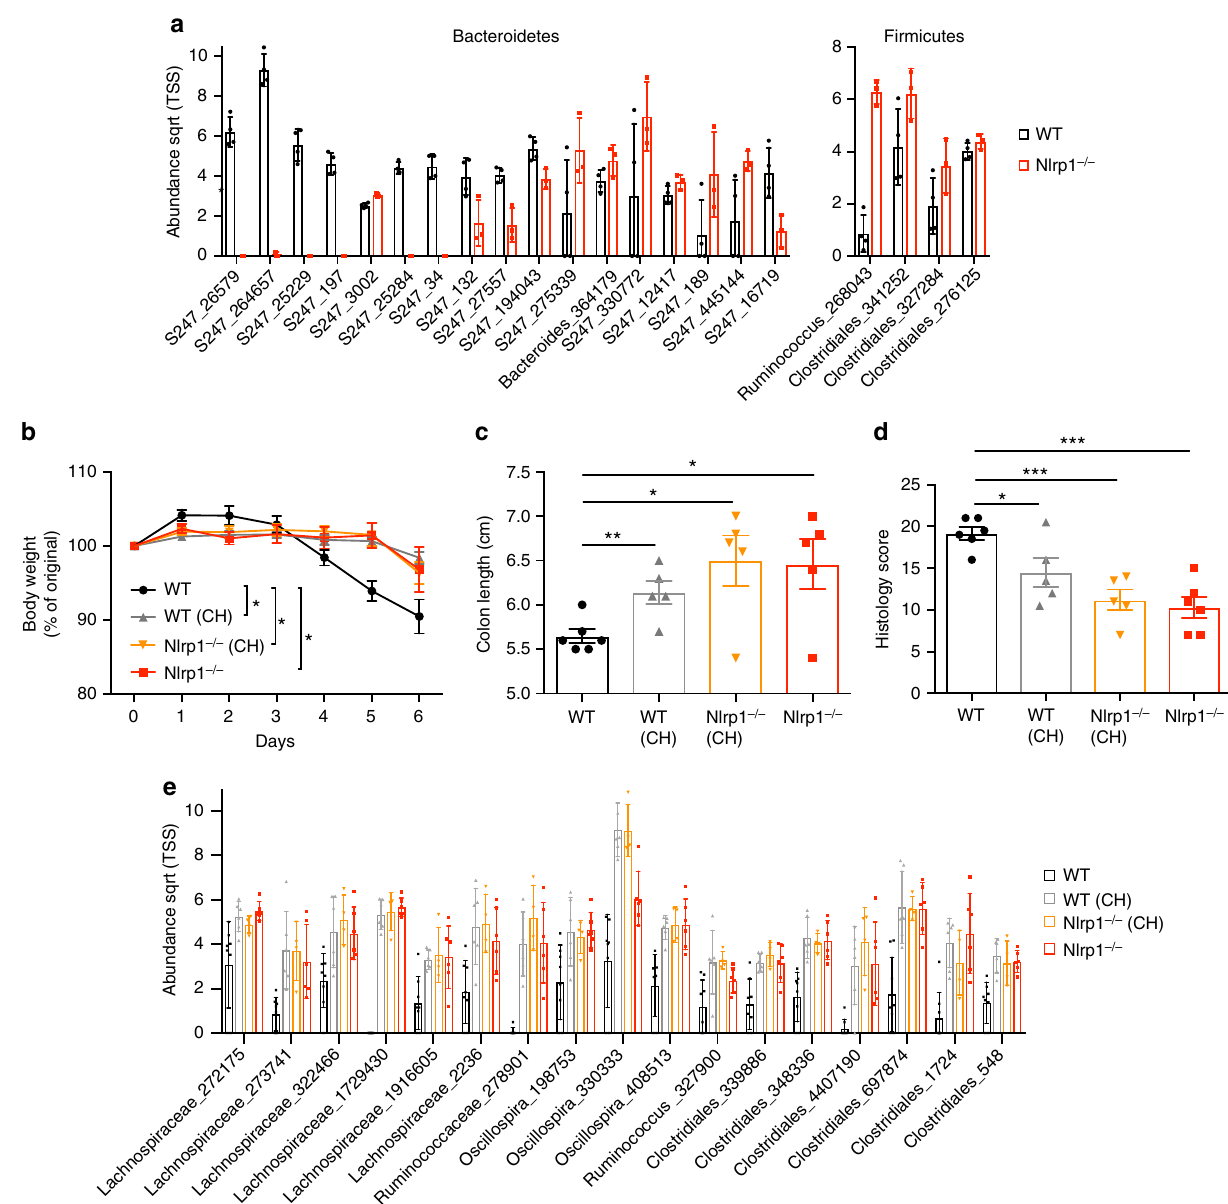
Fig. 2 Microbiome dysbiosis in Nlrp1 − / − mice is transferred to co-housed WT mice. a WT and Nlrp1 − / − littermates were separated at weening for 6 weeks, then stool was collected and subjected to bacterial 16S analysis. Differentially abundant OTUs are presented. b WT mice were either single-housed or co- housed (CH) with Nlrp1 − / − mice for 4 weeks prior to DSS treatment and weight loss, c colon length and d histology score were measured for signs of disease. e Prior to DSS treatment fecal samples were collected for bacterial 16S analysis. Comparison of 16S sequencing showing differentially abundant OTUs in 3 pair-wise comparisons made to WT mice. Data are representative of 2 independent experiments with 3 – 6 mice per group. Means ± SD ( a , e ), means ± SEM ( b – d ); * p ≤ 0.05, ** p ≤ 0.01, *** p ≤ 0.001. As determined by a two-tailed, unpaired t gas chromatography mass spectrometry. A signi fi cant increase real-time PCR (RT-PCR) on stool samples before and after van- of butyrate was observed in Nlrp1 − / − stools compared to WT comycin treatment with speci fi c primers against one major group, Clostridium coccoides 27 . Treatment with vancomycin signi fi cantly stools, which decreased in both cases upon vancomycin treat- reduced the abundance of coccoides in both WT and Nlrp1 − / − ment (Fig. 3d). Signi fi cant differences in other SCFAs, such as mice (Fig. 3a). As expected, depleting the elevated bacteria from propionate, were not observed in WT and Nlrp1 − / − stools at Nlrp1 -de fi cient mice meant that they no longer had a protected steady state, although levels of propionate were reduced after DSS-colitis phenotype compared to WT mice (Fig. 3b, c). To vancomycin treatment (Fig. 3e). In addition, we did not obser- determine whether the protective colitis phenotype of Nlrp1 − / − ve any differences in the total number of CD45 + and CD4 + mice was associated with increased butyrate production by the gut cells in the colon of vancomycin-treated WT and Nlrp1 − / − mice, microbiota, the stools of WT and Nlrp1 − / − mice, before and after with the frequency of IFN γ + (Th1), IFN γ + IL-17a + (Th1/Th17) or IL-17a + (Th17) cells being similar in both genotypes vancomycin treatment, were solvent extracted using a cryomill (Supplementary Fig. 3). and short chain fatty acids (SCFAs) analyzed by triple-quadrupole